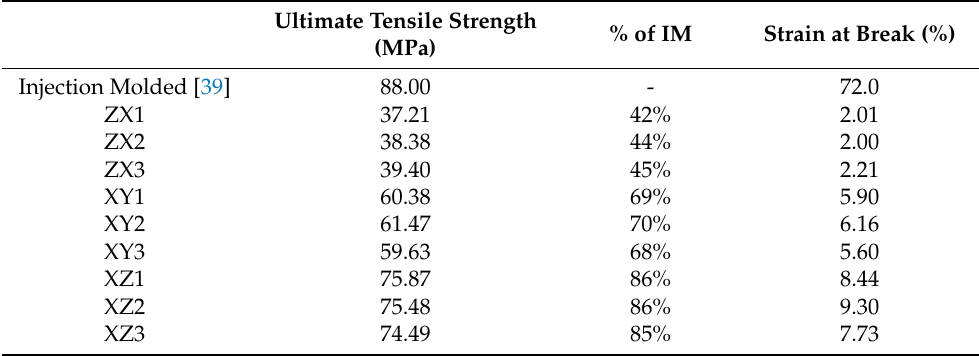
Table 7. Mechanical properties for control specimens in ZX, XY, and